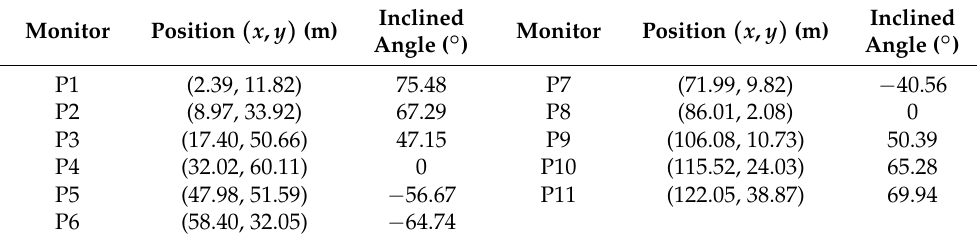
Figure 3. Computational domain and boundary conditions. Table 1. Positions and inclined angles of the monitors in the single-peak